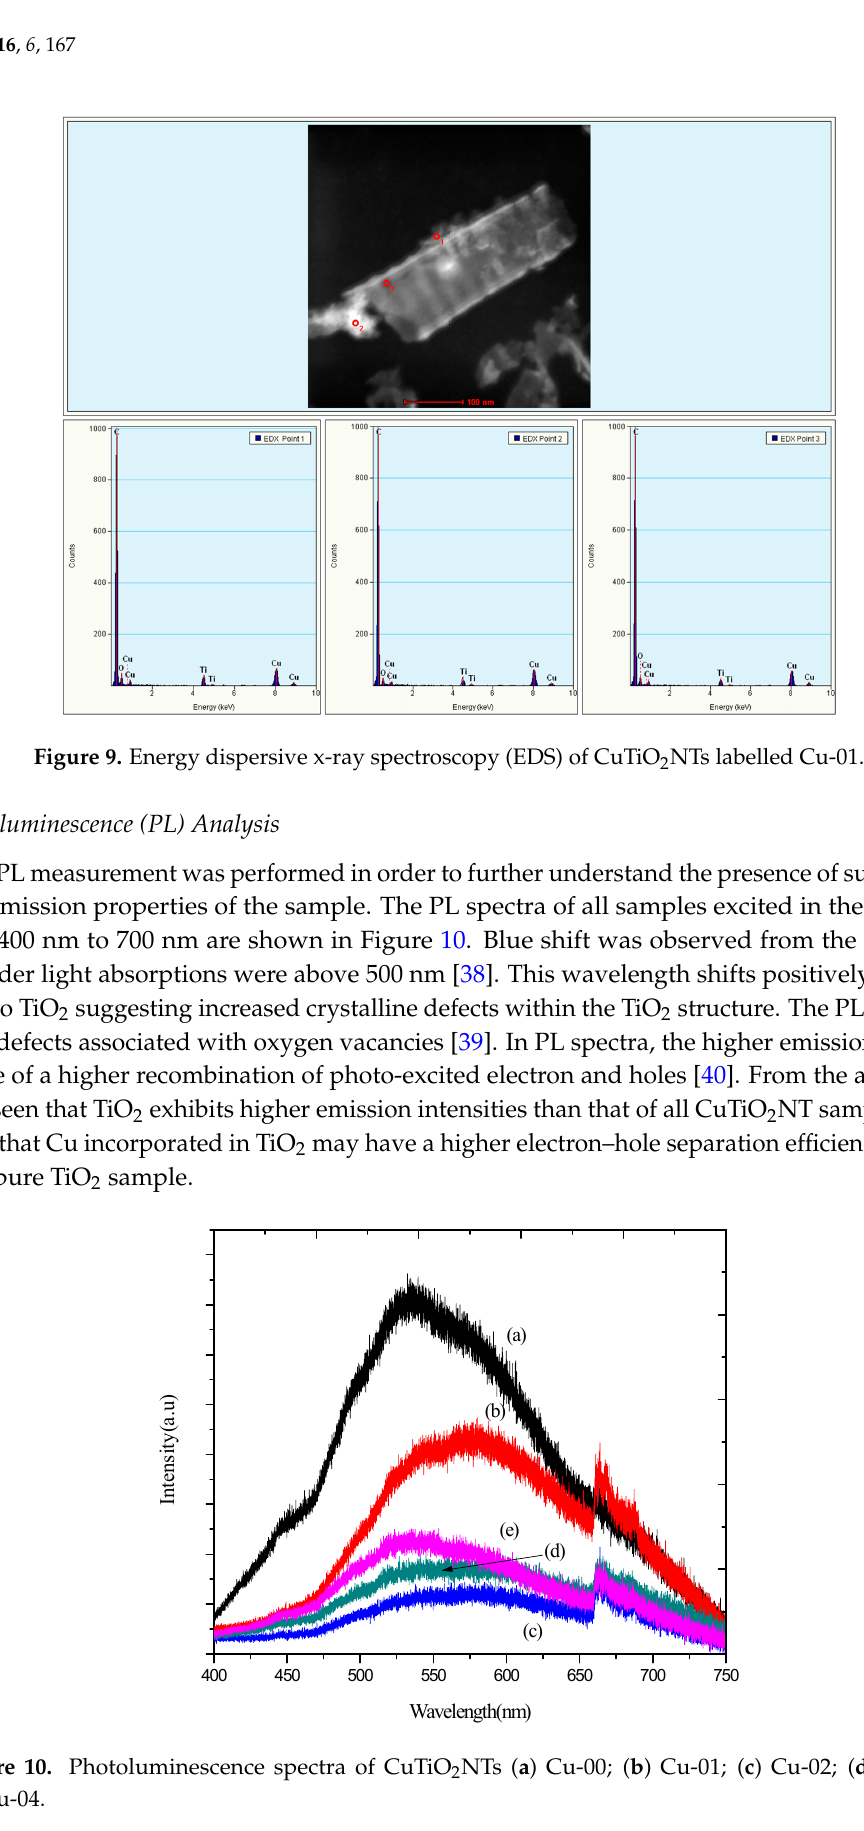
Figure 8. Transmission electron microscopy (TEM) image shows cross sectional morphologies of CuTiO 2 NTs labelled Cu ‐ 01.